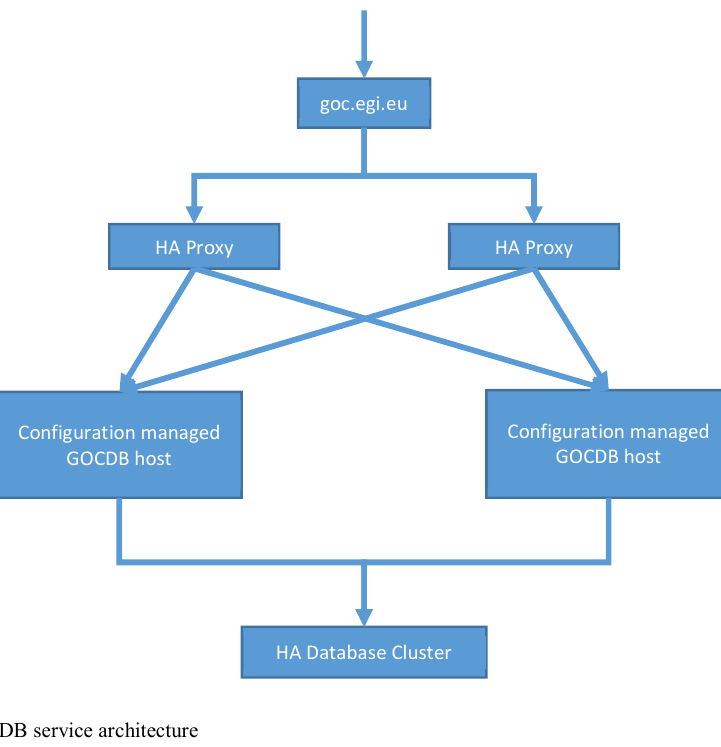
Fig. 6. The future GOCDB service